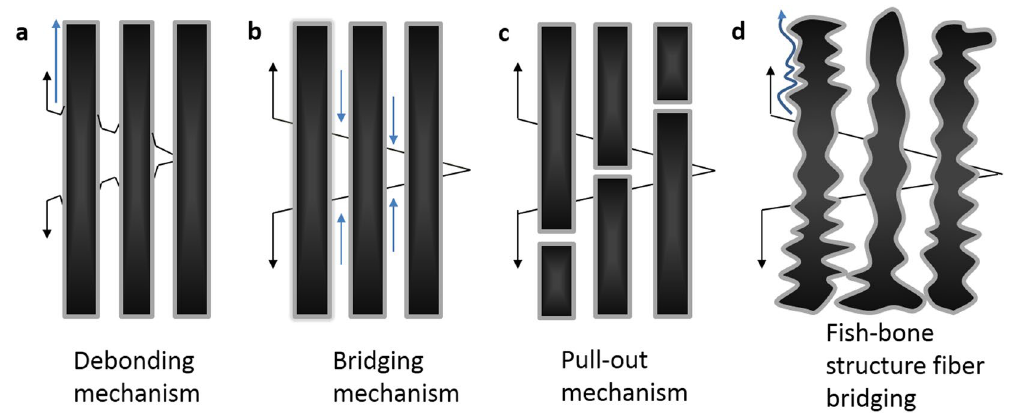
Figure 6. Sketch map of fiber toughening mechanism. ( a ) Interface debonding model, ( b ) bridging mechanism of intact fibers, ( c ) pull-out mechanism of broken carbon fibers ( d ) bridging model of fish-bone structure